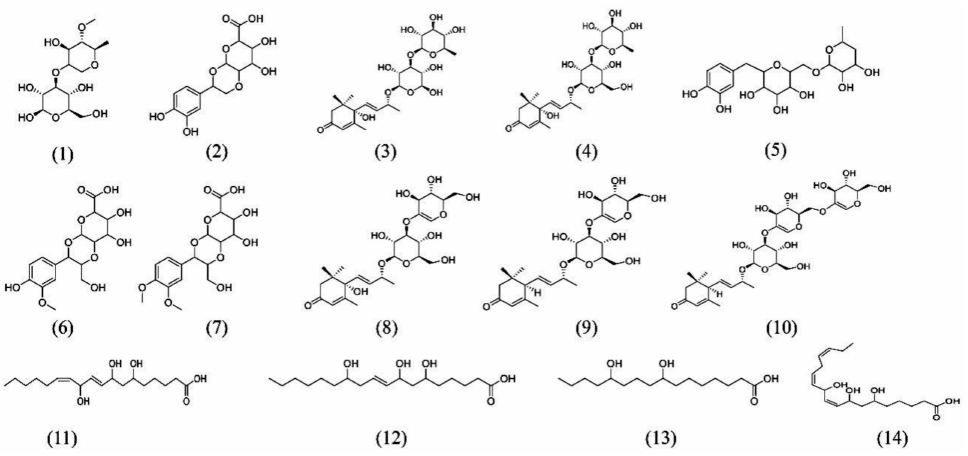
Figure 9. Chemical structures of compounds 1 – 14